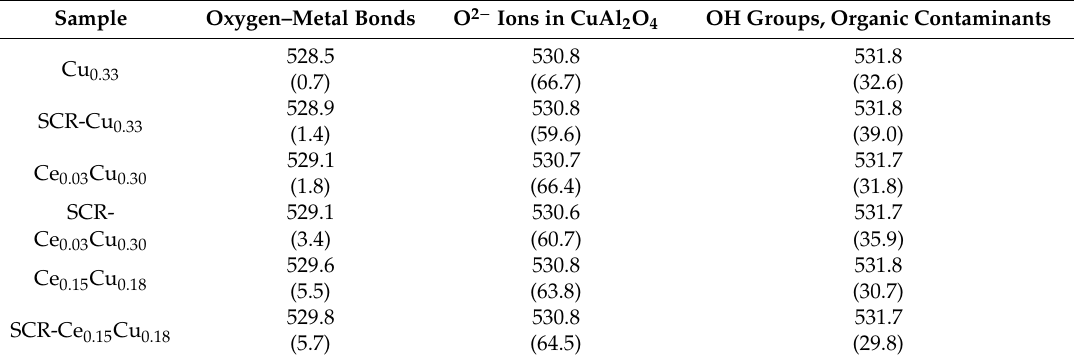
Figure 5. O 1s XPS spectra of Cu–Al parent spinels and doped with cerium for fresh and used catalysts.